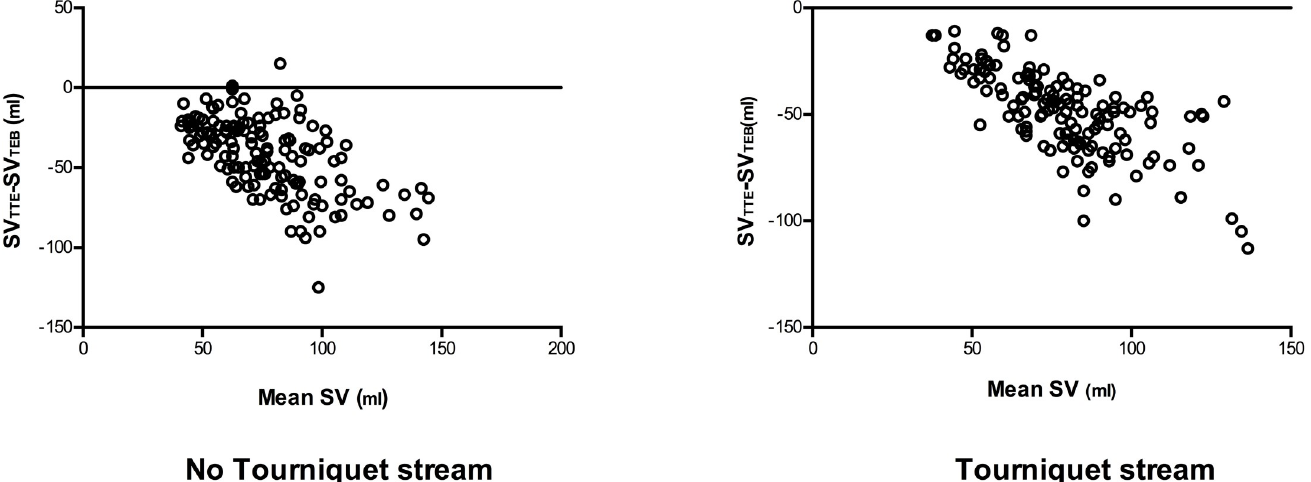
Fig 2. Bland-Altman plot comparing stroke volume (SV) values recorded using thoracic bioimpedence (TBI) and trans-thoracic echocardiography (TTE). Values indicate bias ± SD and 95% limits of agreement.